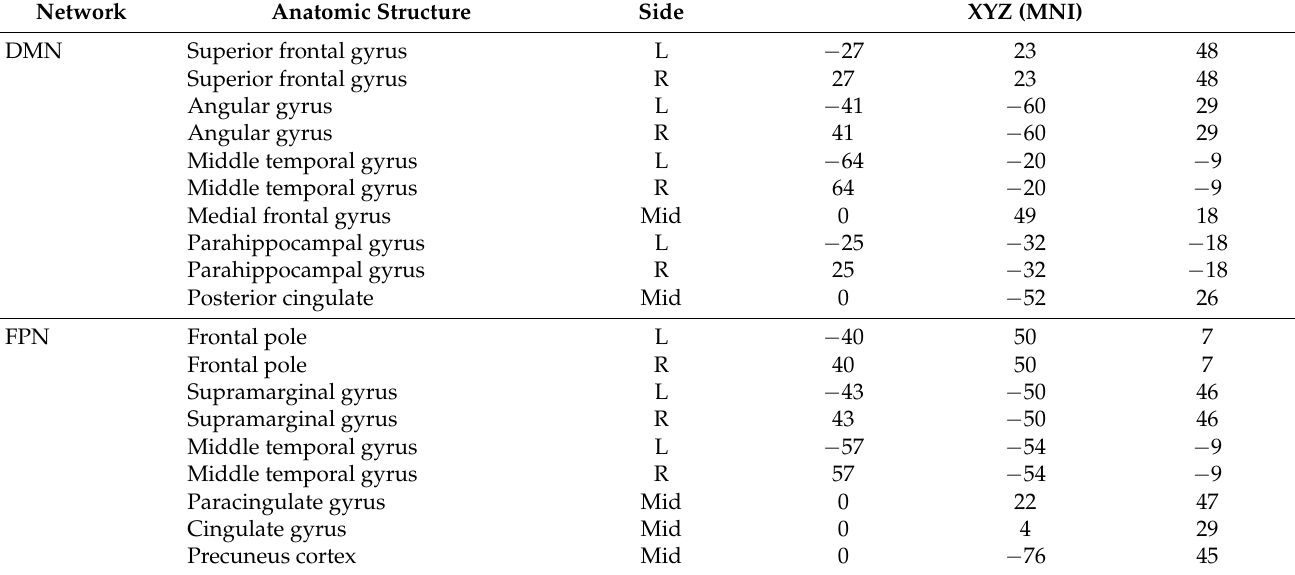
Table 2. MNI coordinates for the seeds from the DMN and